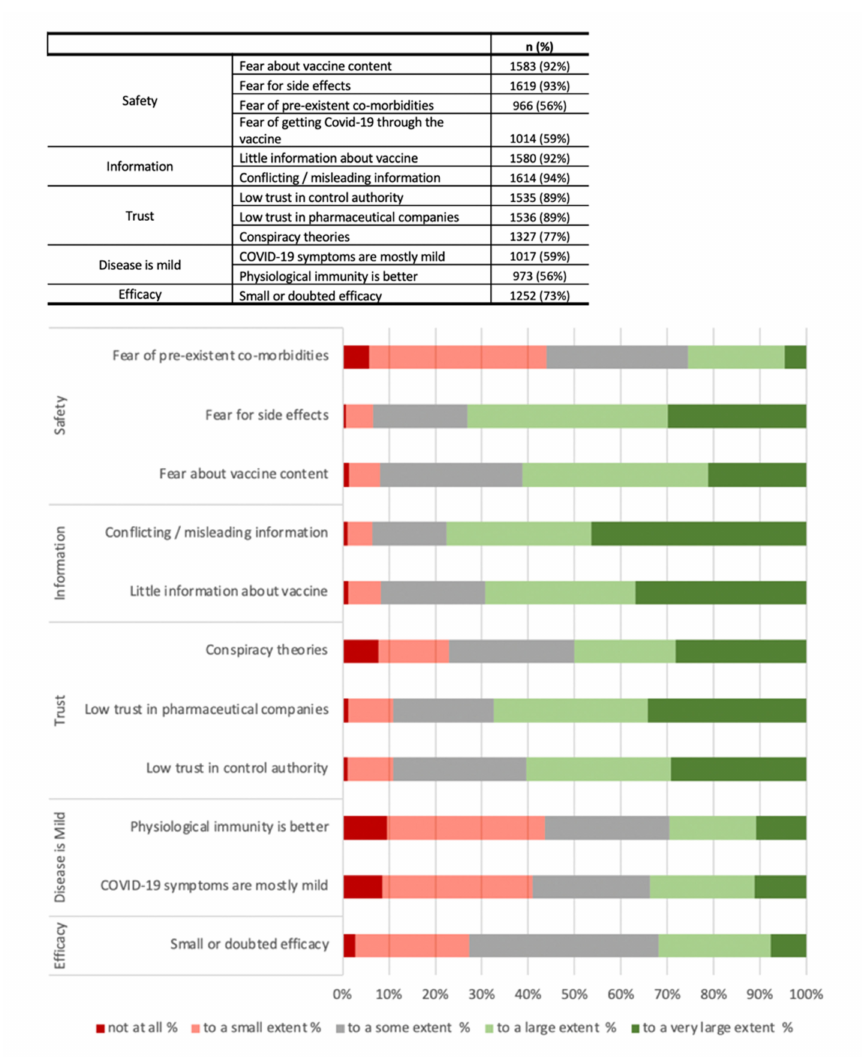
Figure 3. Participants’ opinions on reasons of vaccine hesitancy among the general population.